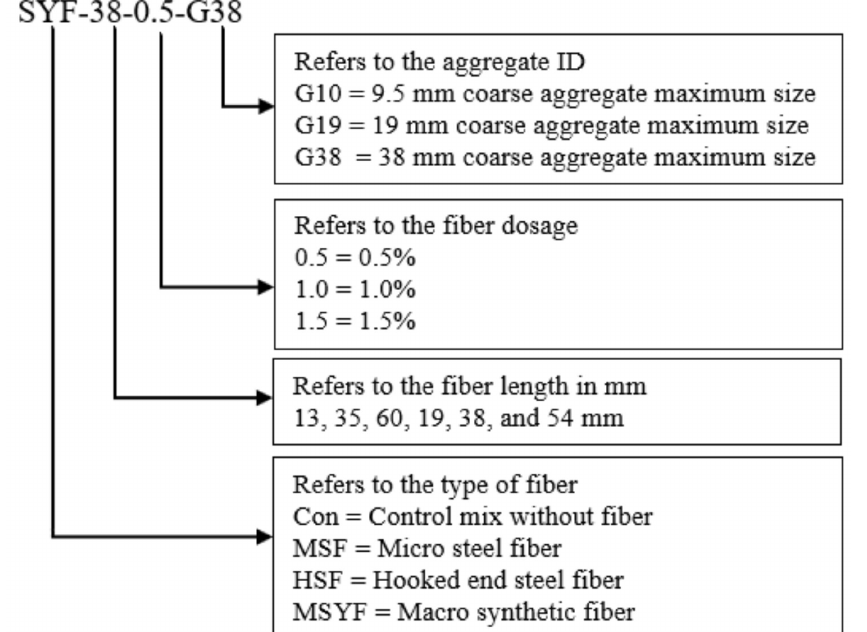
Figure 2. Mix identification chart.